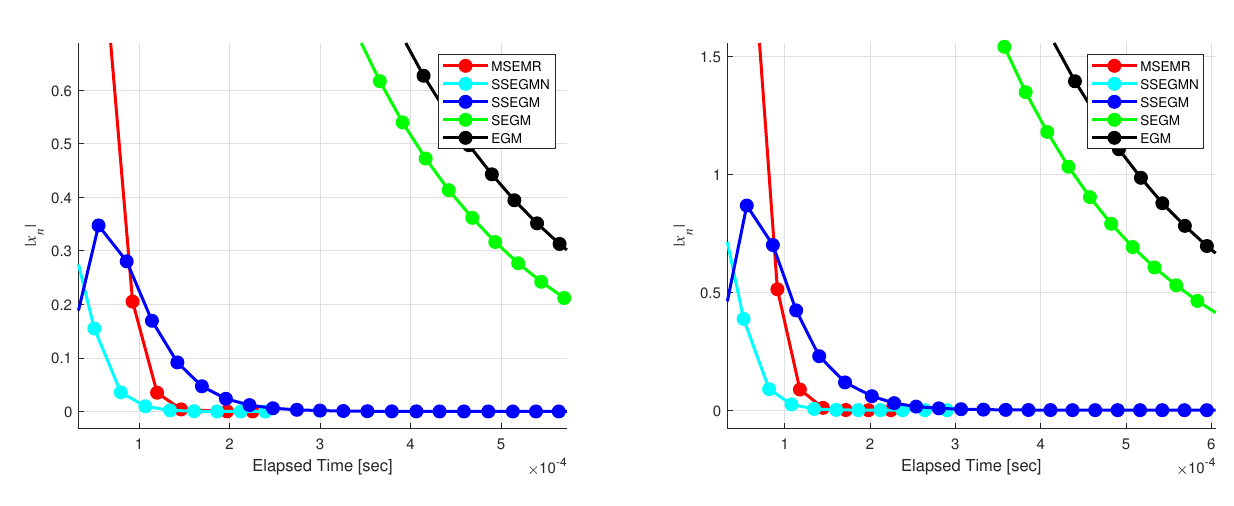
Figure 1. Example 3. Left: x 0 = 4 and x 1 = 2. Right: x 0 = 10 and x 1 = 5.